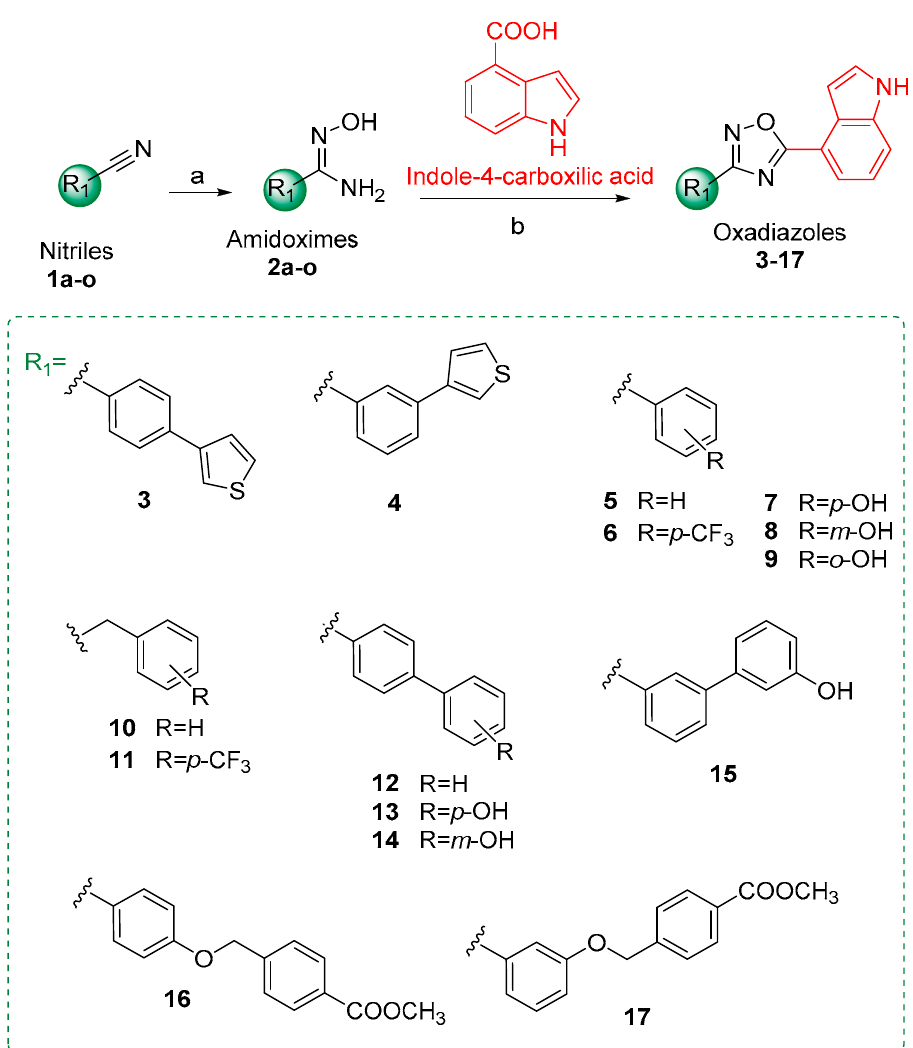
Table 1. In vitro antimicrobial activity of compounds 3 – 17, MIC values are expressed as µM.